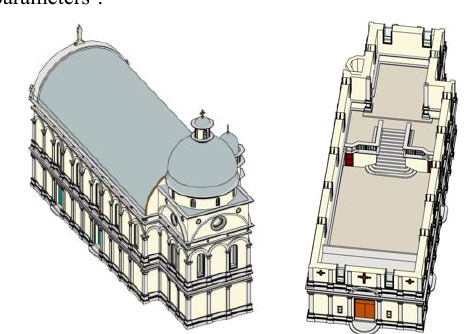
Figure 5. LOD 4. External and internal HBIM modelling.